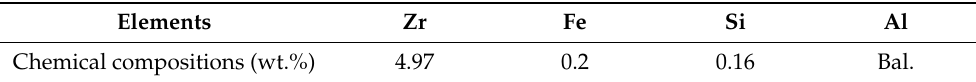
Table 1. Chemical composition of Al-5Zr master alloy used in the experiment. Elements Zr Fe Si Al Chemical compositions (wt.%) 4.97 0.2 0.16